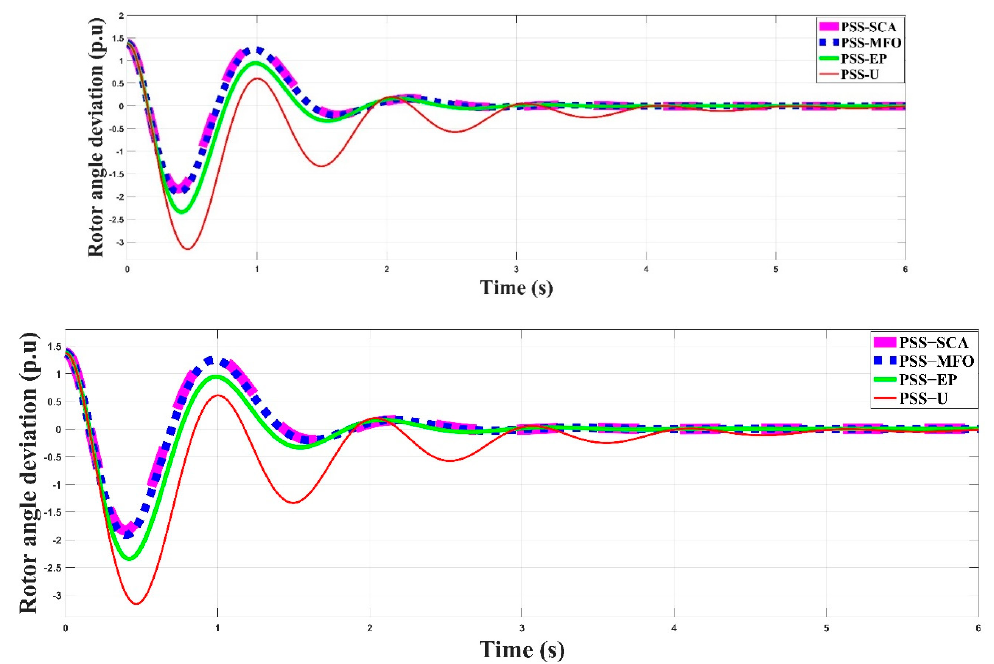
on the left-most of the imaginary axis and is shifted towards the real axis of the s-plane as